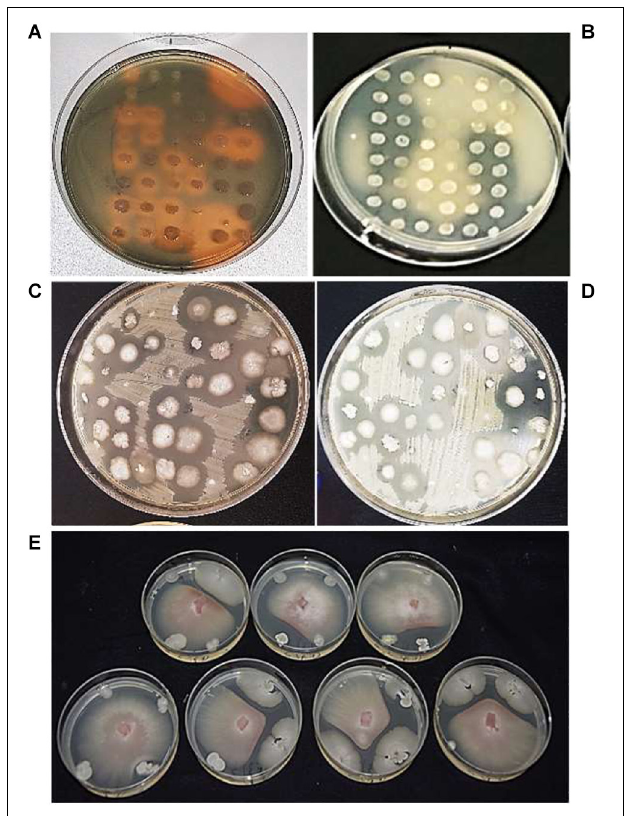
FIGURE 2 | Bacterial isolates, tested for (A) siderophore production, orange halos indicate siderophore positive results; (B) phosphate solubilization, cleared halos indicate phosphate solubilization positive results; antagonistic activity against (C) Xanthomonas euvesicatoria pv. perforans ( Xep ), (D) Pseudomonas syringae pv. tomato ( Pto ), and (E) Fusarium oxysporum f. sp. lycopersici ( Fol